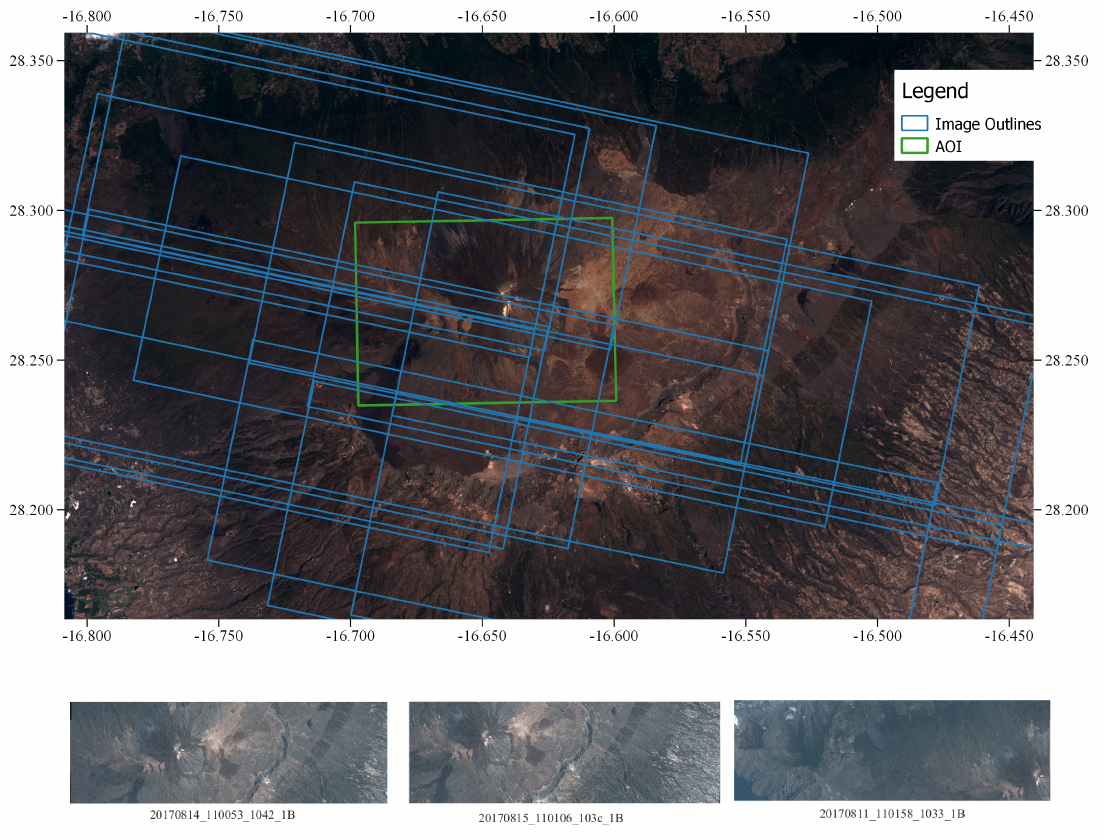
Figure 6. Outlines of PlanetScope Images on a Sentinel Image of Mount Teide. Bottom: Three PlanetScope images are shown here for visual